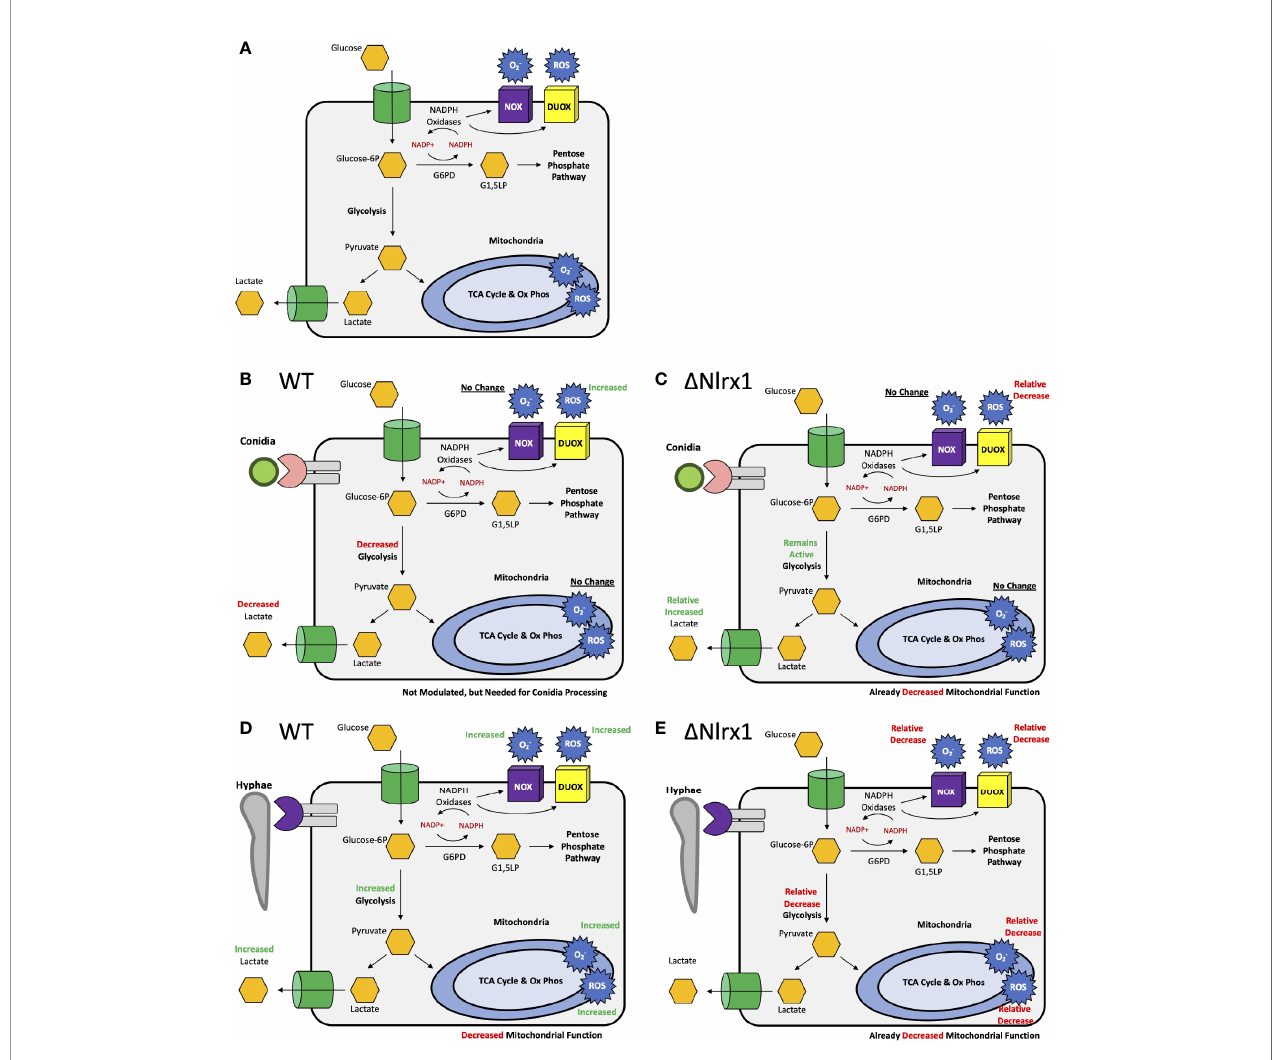
FIGURE 6 | Simpli fi ed, working models for metabolic responses to conidia and hyphae in airway epithelial cells and their dependency on Nlrx1. (A) Simpli fi ed representation of glycolysis, the pentose phosphate pathway, oxidative phosphorylation, ROS, and superoxide production. Modulation of these pathway in response to (B) conidia and (D) hyphae by wild-type cells. Relative modulation of these pathways in response to (C) conidia and (E) hyphae by Nlrx1-de fi cient cells in comparison to wild